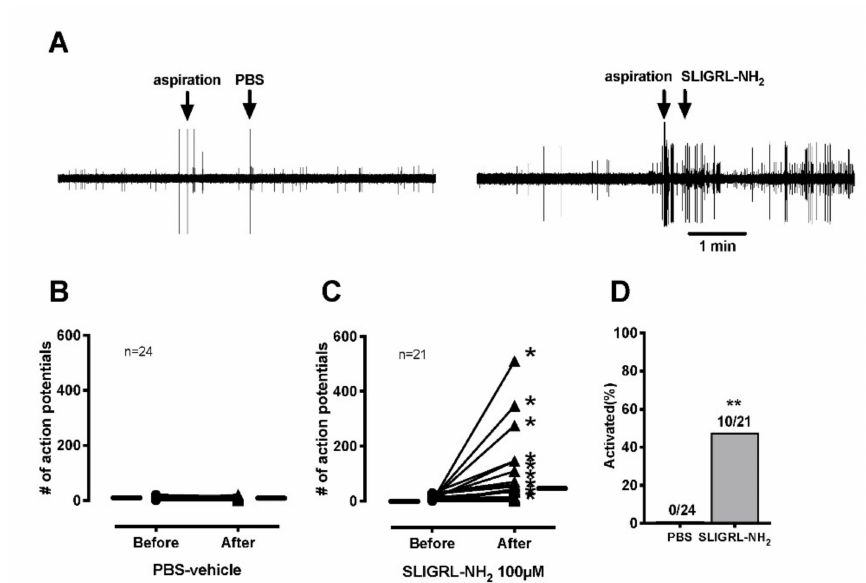
Figure 3. Effects of PAR-2 agonist SLIGRL-NH 2 or vehicle on ongoing activity of mechanonociceptive C-fibers. Each fiber was tested with one application, either PBS or SLIGRL-NH 2 . ( A ) Example recordings of from 2 different C-fibers before and after application of PBS-vehicle or 100 µ M SLIGRL- NH 2 . ( B , C ) Ongoing activities of C-fibers before and after exposure to 100 µ M SLIGRL-NH 2 or PBS- vehicle. Each line on the graphs represents a single unit. Asterisks indicate activation of nociceptors by drug application. Small horizontal lines in each graph indicate median values. ( D ) The proportion of C-fibers responsive to application of SLIGRL-NH 2 or PBS-vehicle. A total of 24 units for PBS and 21 units for SLIGRL-NH 2 were used.